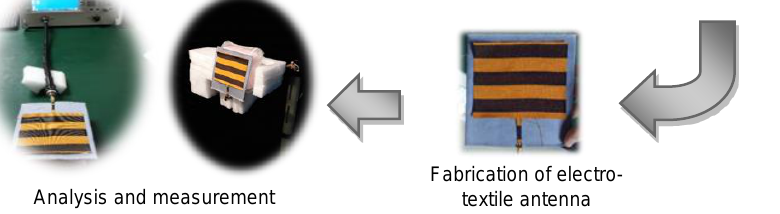
Figure 3. A flowchart showing the overall process of fabrication, characterization, design, simulation, measurement and analysis of the electro-textile antenna performance in on-body conditions.